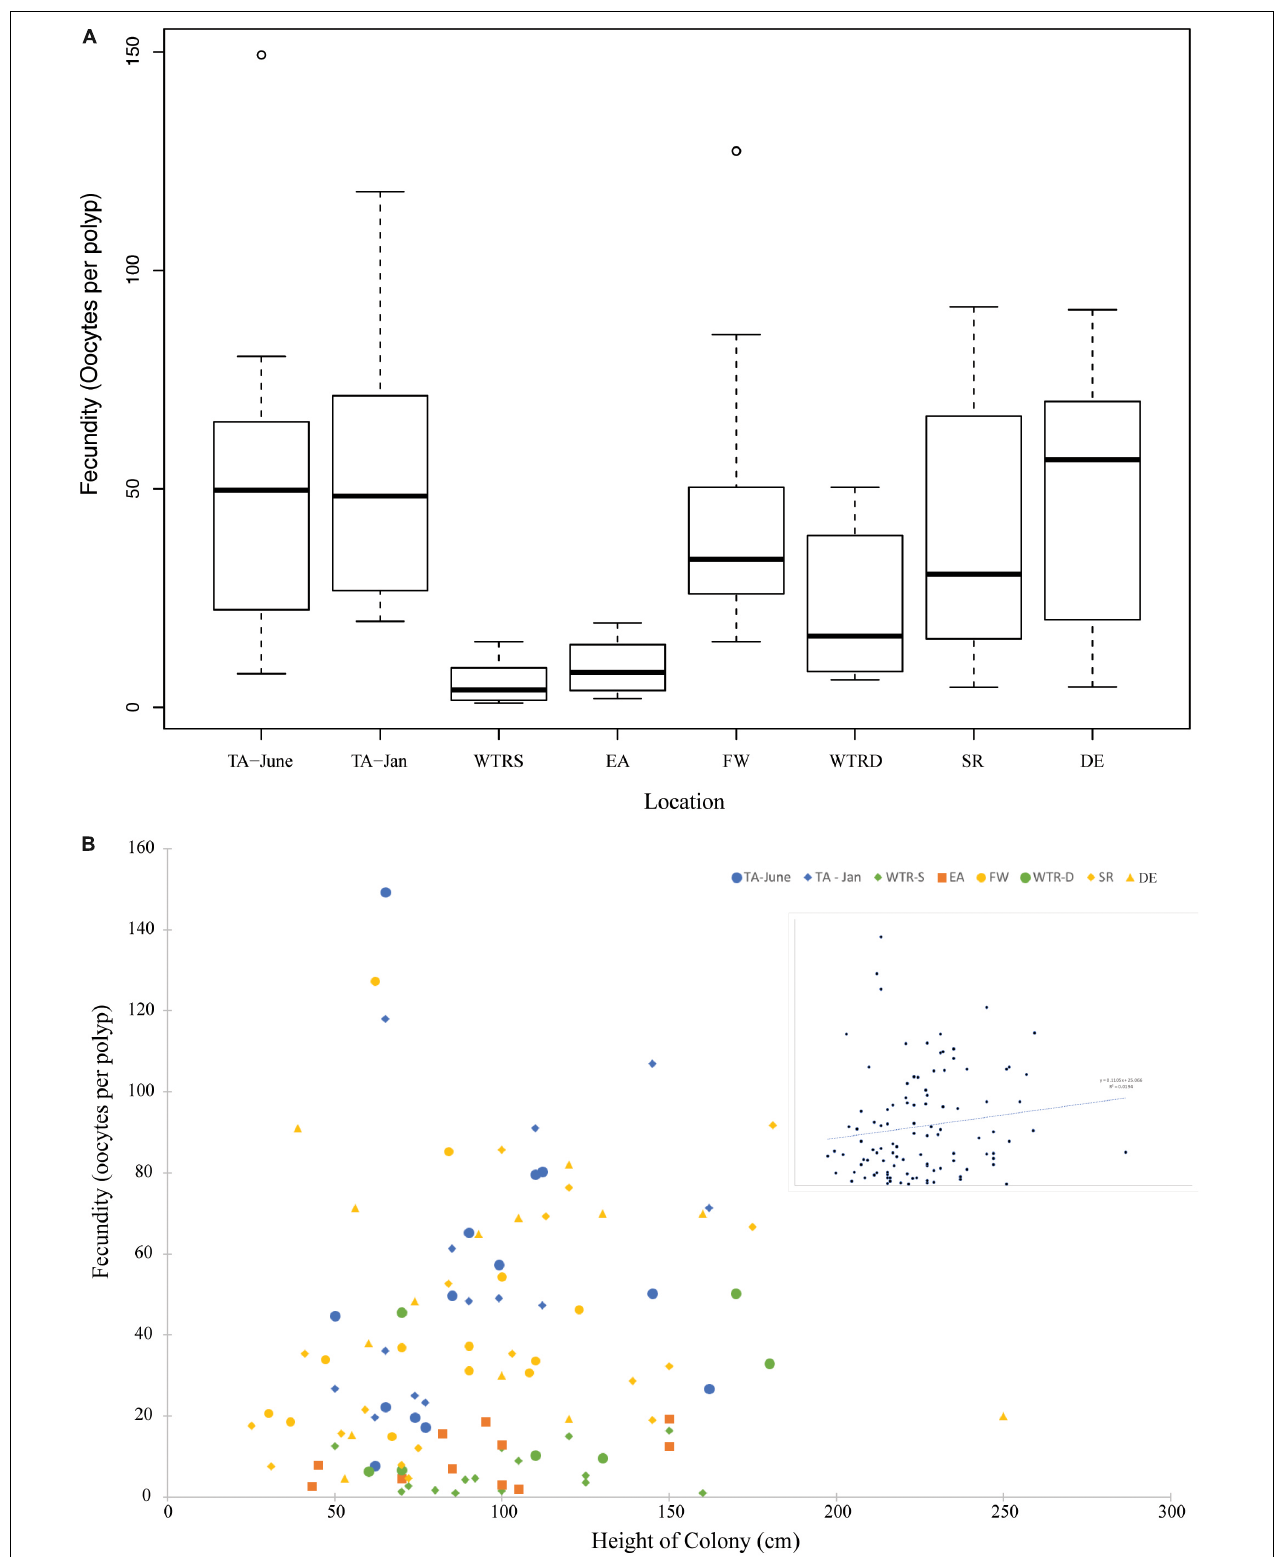
FIGURE 5 | (A) Boxplot showing total fecundity by study site. Sites are arranged from shallowest (left) to deepest (right). (B) The relationship of fecundity and colony height for all females in this study. Colors represent different locations and inset shows relationship for all colonies combined. The trend line is linear.